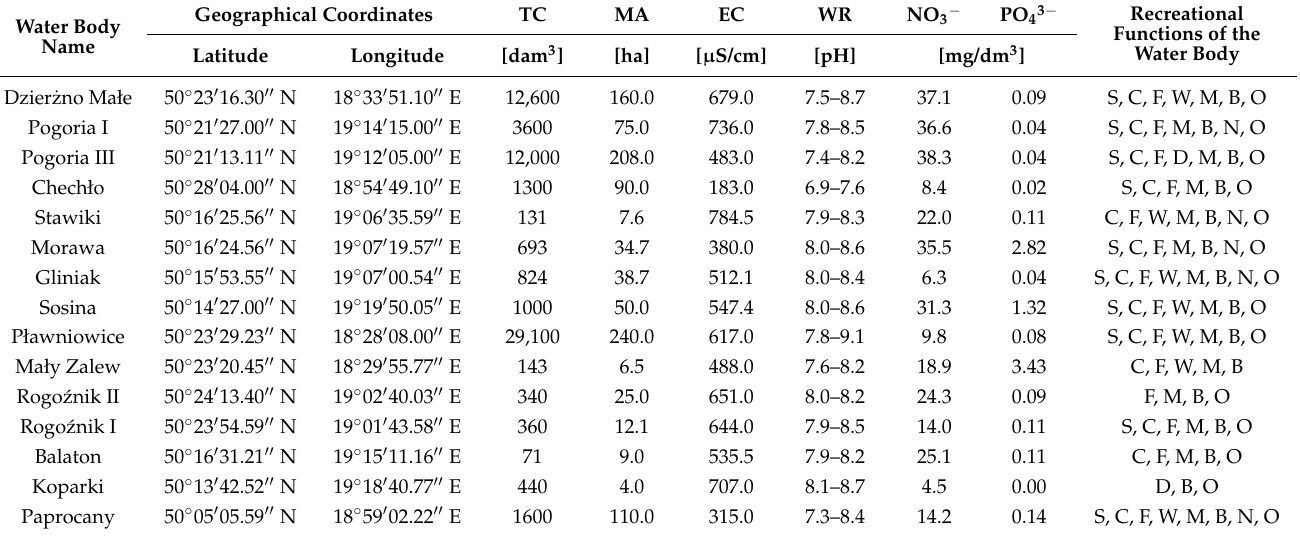
Table 1. Morpho- and hydrometric parameters of the water bodies in the Silesian